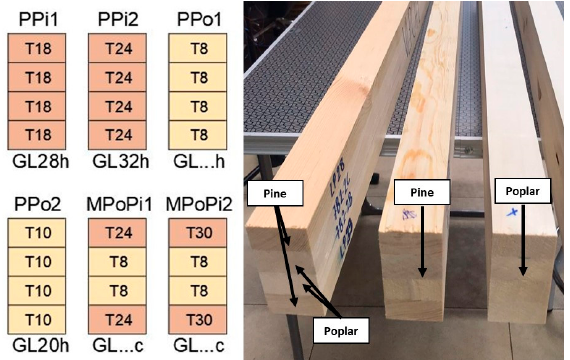
Figure 5. Timber layers design according with planks grading and strength class GL proposed by the standard [26]. PPi: single-species pine. PPo: single-species poplar. MPoPi: mixed poplar/pine. GLXc: design grading for combined. GLXh: design grading for homogeneous.